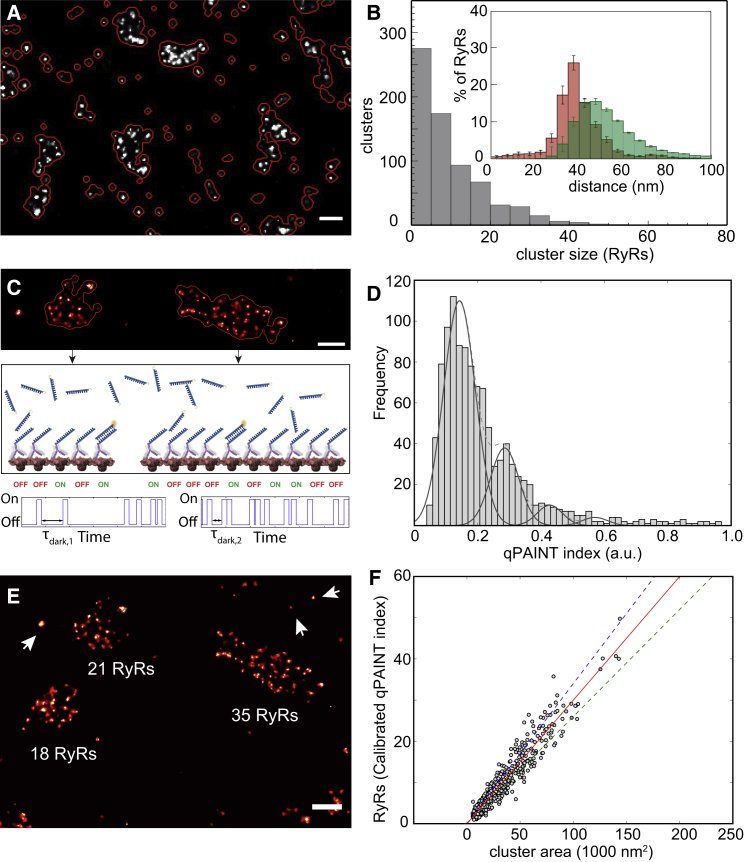
Quantitative Analysis of RyR Cluster Properties(A) Clusters were segmented using an algorithm that contours the image based on local event density (red lines).(B) A frequency histogram of RyR puncta counted within segmented peripheral RyR clusters typically consisted of fewer than 40 RyRs (mean ± SD = 8.81 ± 3.56 RyR/cluster; n = 17 cells, 10 animals); the distribution of nearest neighbor puncta centroid distances within clusters with 5 or more RyRs (see inset; red) showed a mean of 40.1 ± 0.9 nm (mean ± SEM; n = 1,802 clusters, 8 animals). The average of the 4 nearest neighbor distances (green) was a right-shifted distribution (58.9 ± 0.9 nm). Error bars (inset): SEM for n = 17 cells.(C) qPAINT estimates the number of docking sites by analyzing the temporal sequence of single-molecule event detections recorded at a given cluster. Two clusters are shown (upper panel), one larger than the other. The rate at which imagers bind to RyRs in a cluster is proportional to the number of RyRs in the cluster (middle and lower panels).(D) The “qPAINT indices” of small clusters containing ∼1 punctum provided a calibration to “count RyRs”; its histogram exhibits equidistant peaks characteristic of quantal increments in imager strand binding sites with a primary maximum of 0.14 qPAINT index units, equivalent to a single RyR.(E) Examples of the RyR counts estimated from calibrating the qPAINT index values for three nearby large clusters show the close correspondence with counted puncta numbers.(F) Scatterplot of cluster area versus qPAINT estimated RyR counts. A linear regression (solid line) of the scattergram provides an estimate of the two-dimensional area of packing as 1 RyR per 3,300 nm2 for this dataset from one cell (391 clusters). Dashed lines indicate 15% variation of slope.Scale bars in (A) and (E), 200 nm.